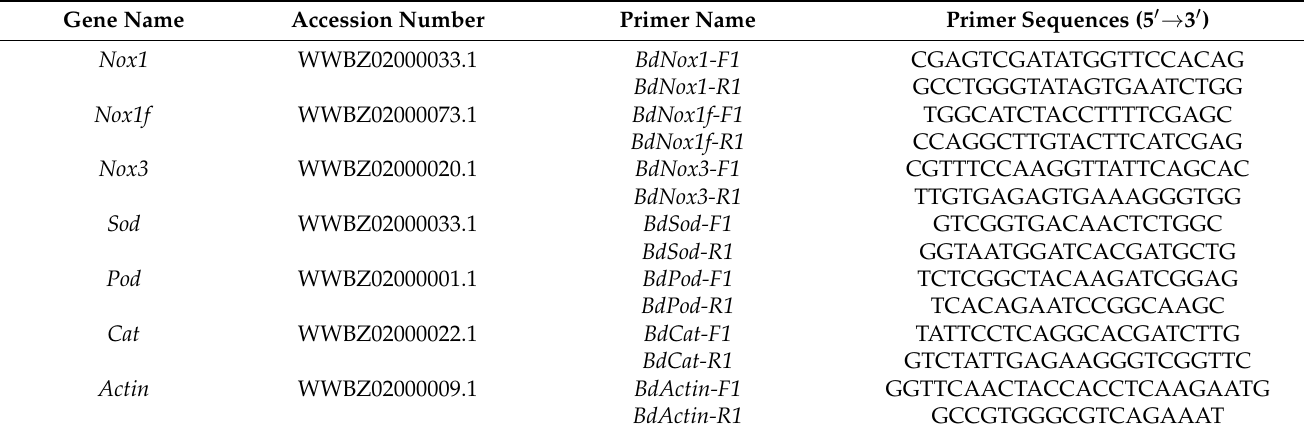
Table 1. Primers Used for the RT-qPCR